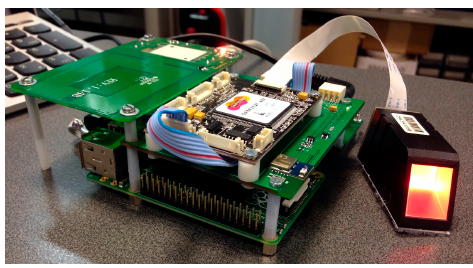
Figure 10. Hardware configuration of the second prototype.